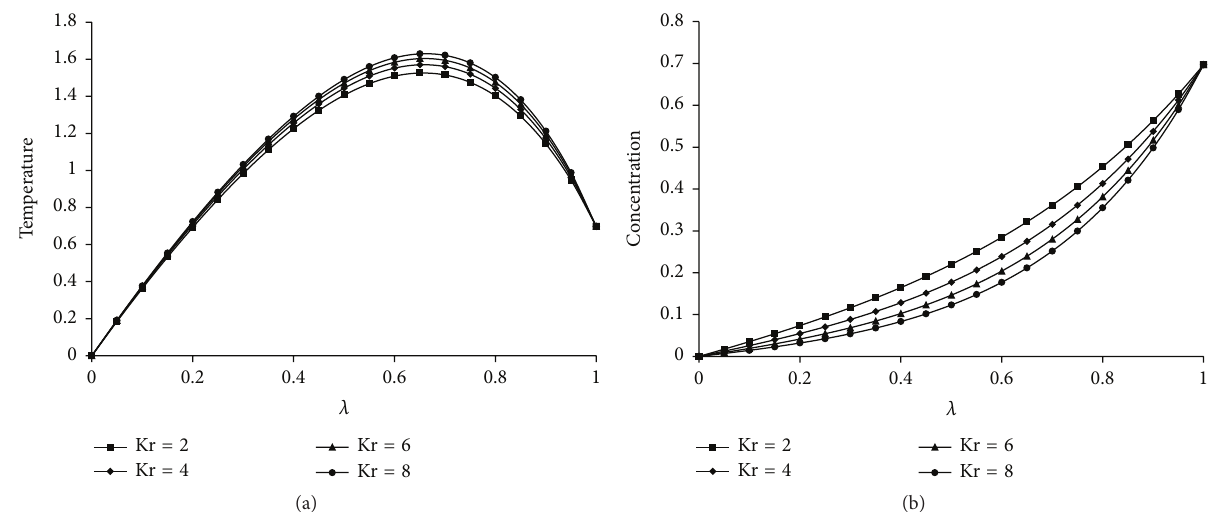
Figure 4: Effect of Du on (a) temperature and (b) concentration for Du = 1, Gr = 4, Gm = 4, Re = 2, Sr = 0.2, Sc = 0.22, Pr = 1, 𝑎 = 0.2 , 𝜓 = 0.8 , = 0.2 , 𝑠 = 2 , 𝑠 = 10 , Ha = 2, 𝐷 −1 = 2 , and Ec = 1. 𝑅 = 2 , 𝐽 1 1 2